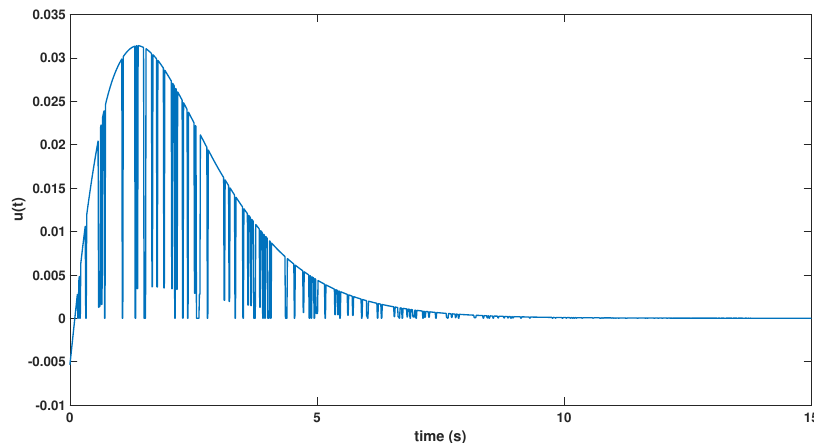
Figure 9. Control input trajectory of one-area power system.